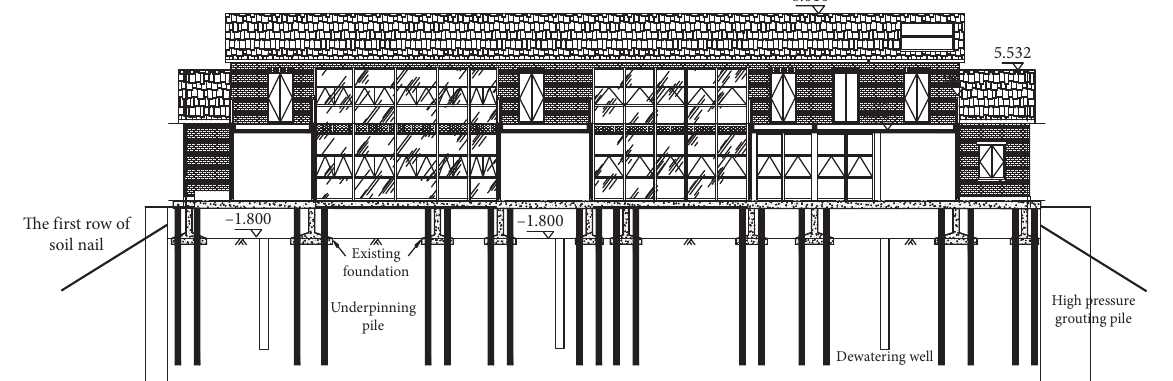
Figure 4: Excavation the first soil layer and construction underpinning pile (unit: